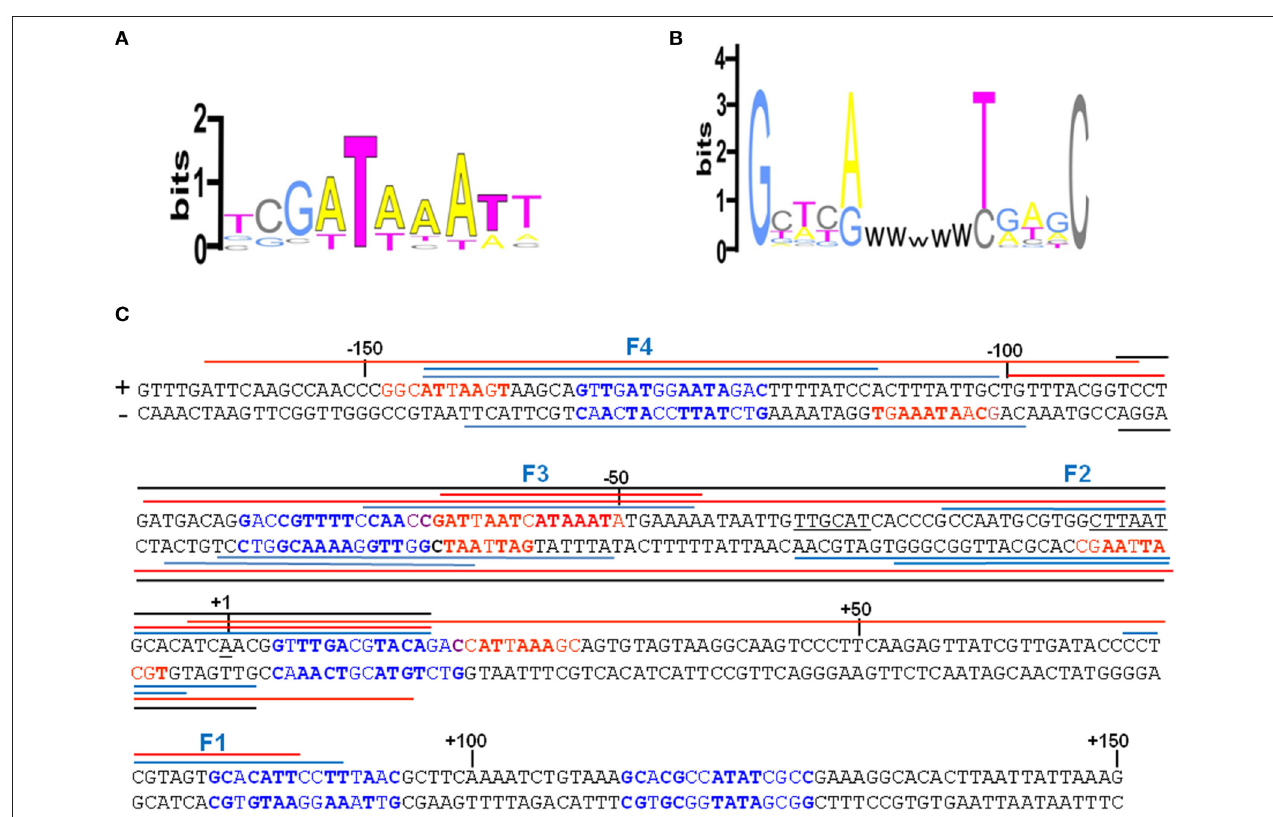
FIGURE 4 | Localization of FIS and H-NS binding sites found within the cspA promoter region. (A) Logo representation of the H-NS binding motif (Lang et al., 2007 ). (B) Simplified version of the Logo for the FIS binding motif proposed by Shao et al. (2008). W = A or T. (C) The sequence of the promoter region of cspA ( − 167 to + 150) is shown, with the transcriptional start point ( + 1), the − 10 and − 35 consensus promoter elements underlined in black. The bases in red represent the in silico predicted H-NS binding sites matching at least 4/6 bases of the core sequence of the H-NS binding motif and displaying less frequent bases in the other positions, while the bases in blue represent the in silico predicted FIS binding sites according to the FIS logo shown in (B) . The bases in bold match those found more frequently in the H-NS and FIS binding sites, respectively. The colored lines placed above or below the + and − strand, respectively, indicate the protections from DNase I digestion found with H-NS alone (red), FIS alone (blue), or with a mixture of FIS and H-NS (black). Overlapping lines indicate DNase I footprintings found in independent experiments ( Figure 3 , Figures S3, S4 in Supplementary Material and other not shown). The protections were identified using either a 310bp cspA fragment (for FIS, H-NS, and FIS+H-NS) or a 1200 bp cspA fragment (for FIS and H-NS